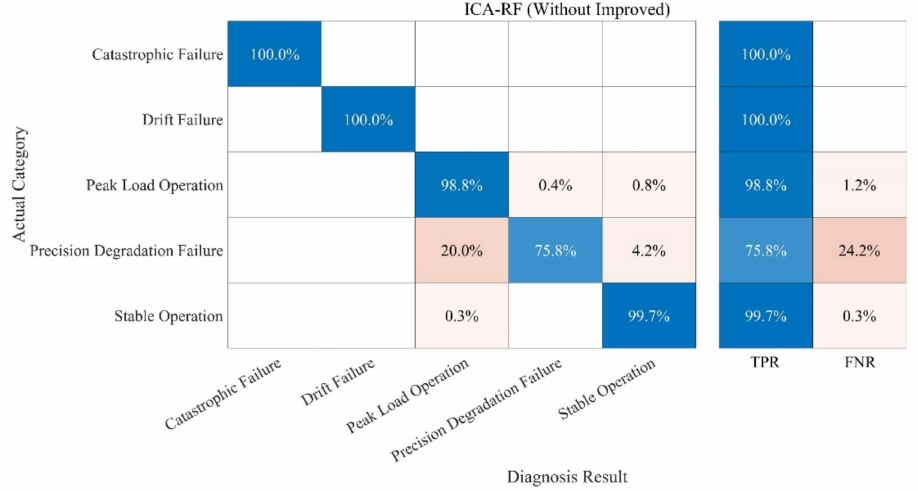
Figure 17. Fault Diagnosis Result of ICA-RF (Without Improved).